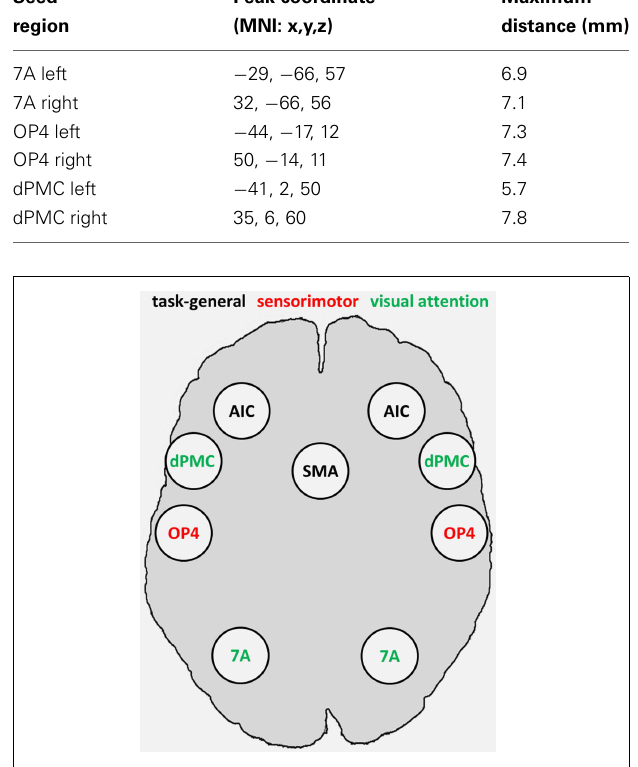
FIGURE 3 | Combined set of seed regions (schematic), comprising fMRI-based seed regions (visual attention and sensorimotor) derived from Roski et al. (2013) and task-general regions derived from meta-analytic connectivity modeling. 7A, superior parietal lobule area 7A; AIC, anterior insular cortex; dPMC, dorsal premotor cortex; OP4, area OP4 of the parietal operculum; SMAr, rostroventral supplementary motor